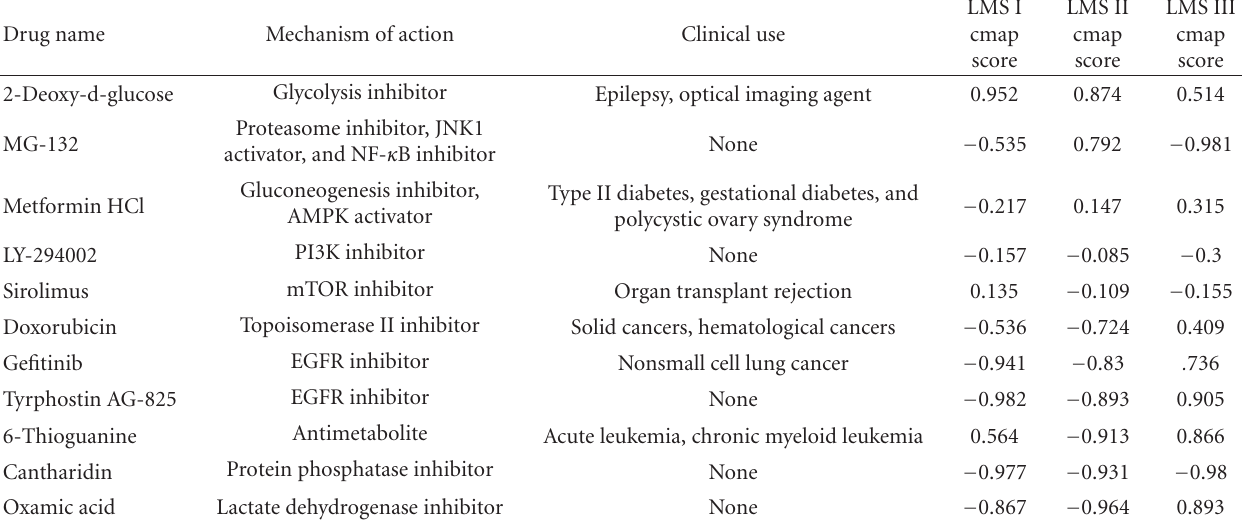
Table 1: Mechanisms of action and cmap enrichment scores for drugs tested in LMS cell